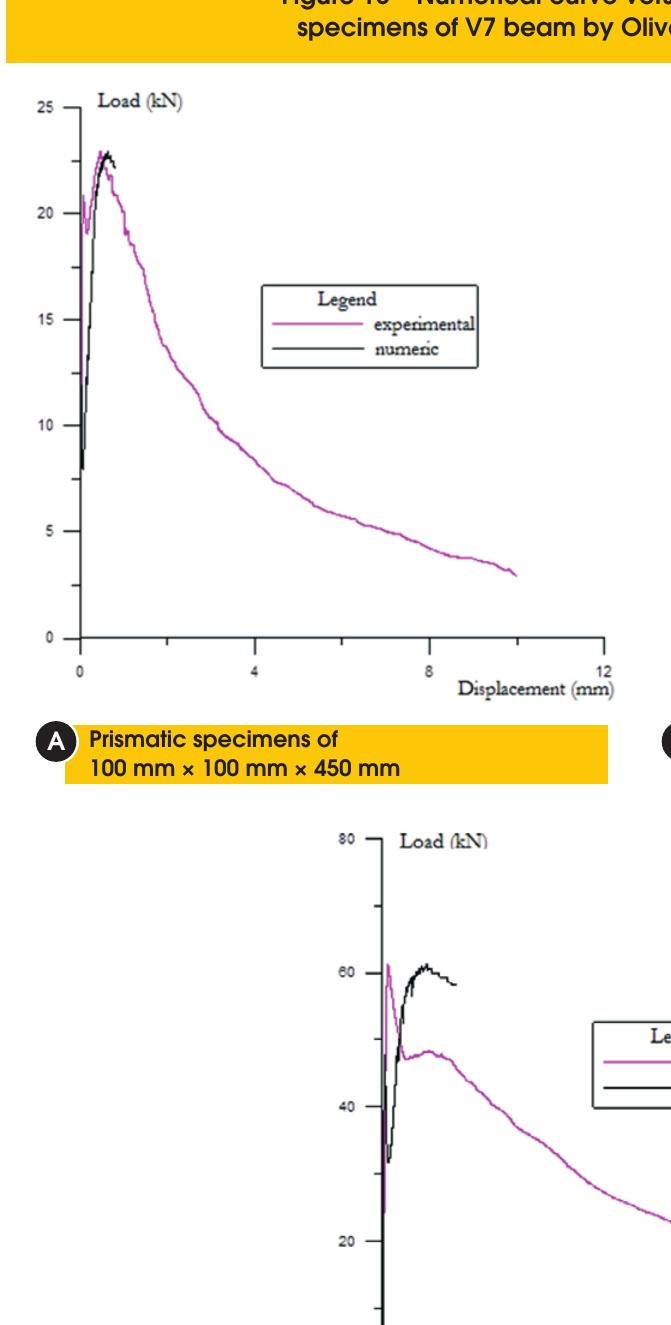
Figure 18 – Numerical curve versus experimental prismatic specimens of V7 beam by Oliveira [17] with 0.50%